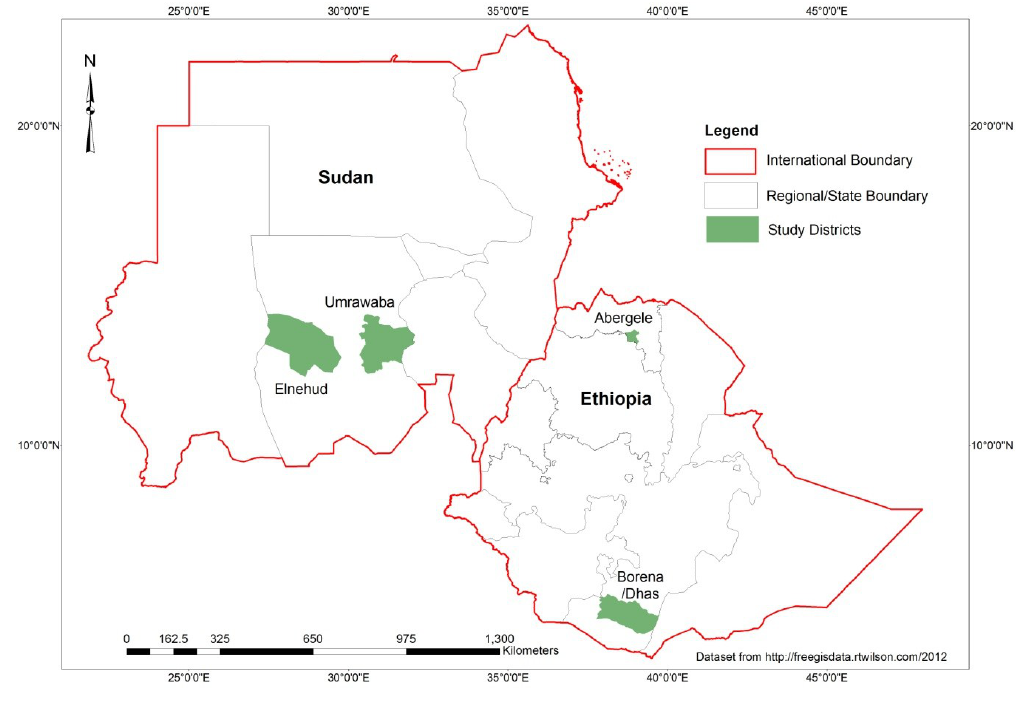
Figure 1. Map of the four case study areas in the drylands of Sudan and